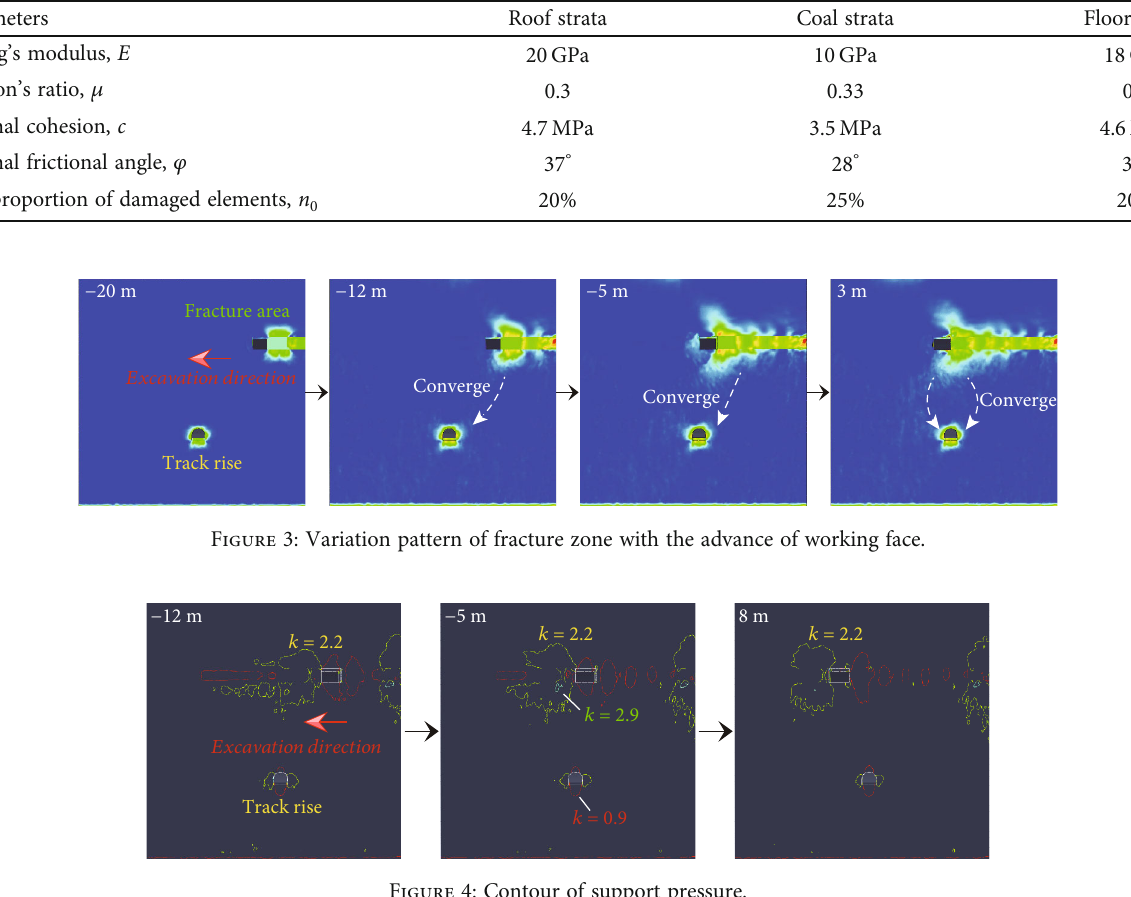
Figure 4: Contour of support pressure.